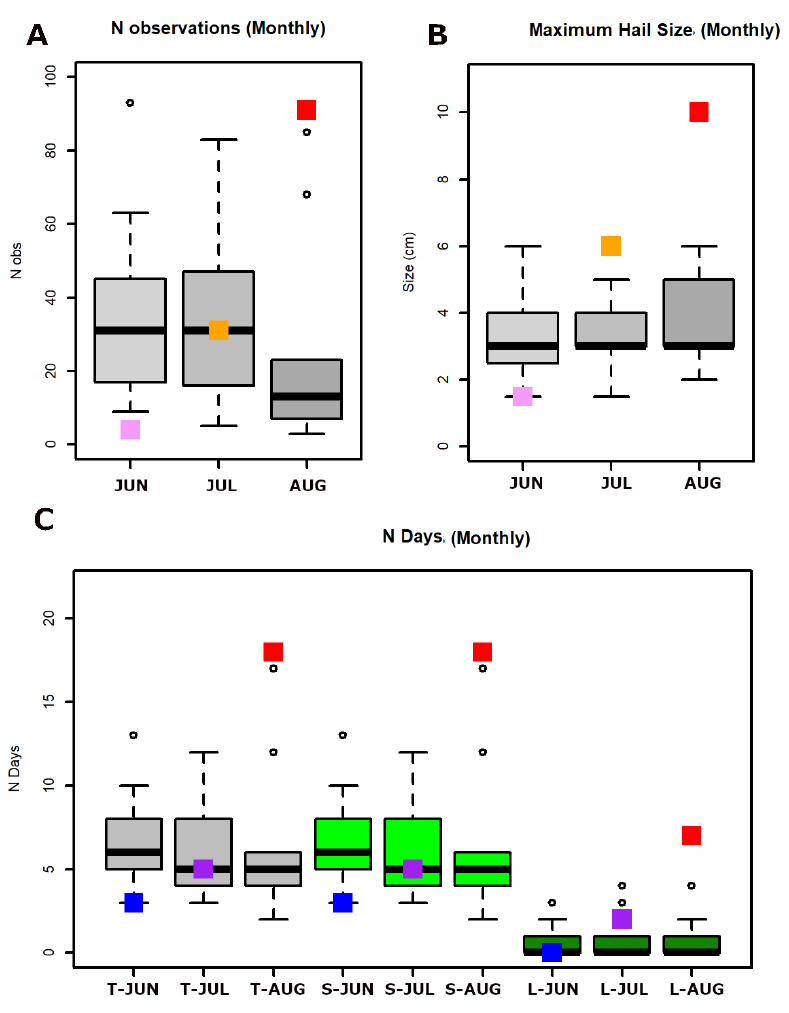
Figure 3. Box plots of the monthly values (only summer), for the period of 2013–2021, of ( A ) the number of observations, ( B ) the maximum hail size recorded, and ( C ) the number of days (total in grey, with severe hail in green, and with very large hail in dark green. From left to right : June, July, and August). In panels A,B , the light grey boxes correspond to June, grey to July, and dark grey to August. The squares (pink for June, orange for July, and red for August in panels A,B , and blue for June, purple for July, and red for August in panel C , repeated from left to right for total, severe, and very large hail days) indicate the values for the year